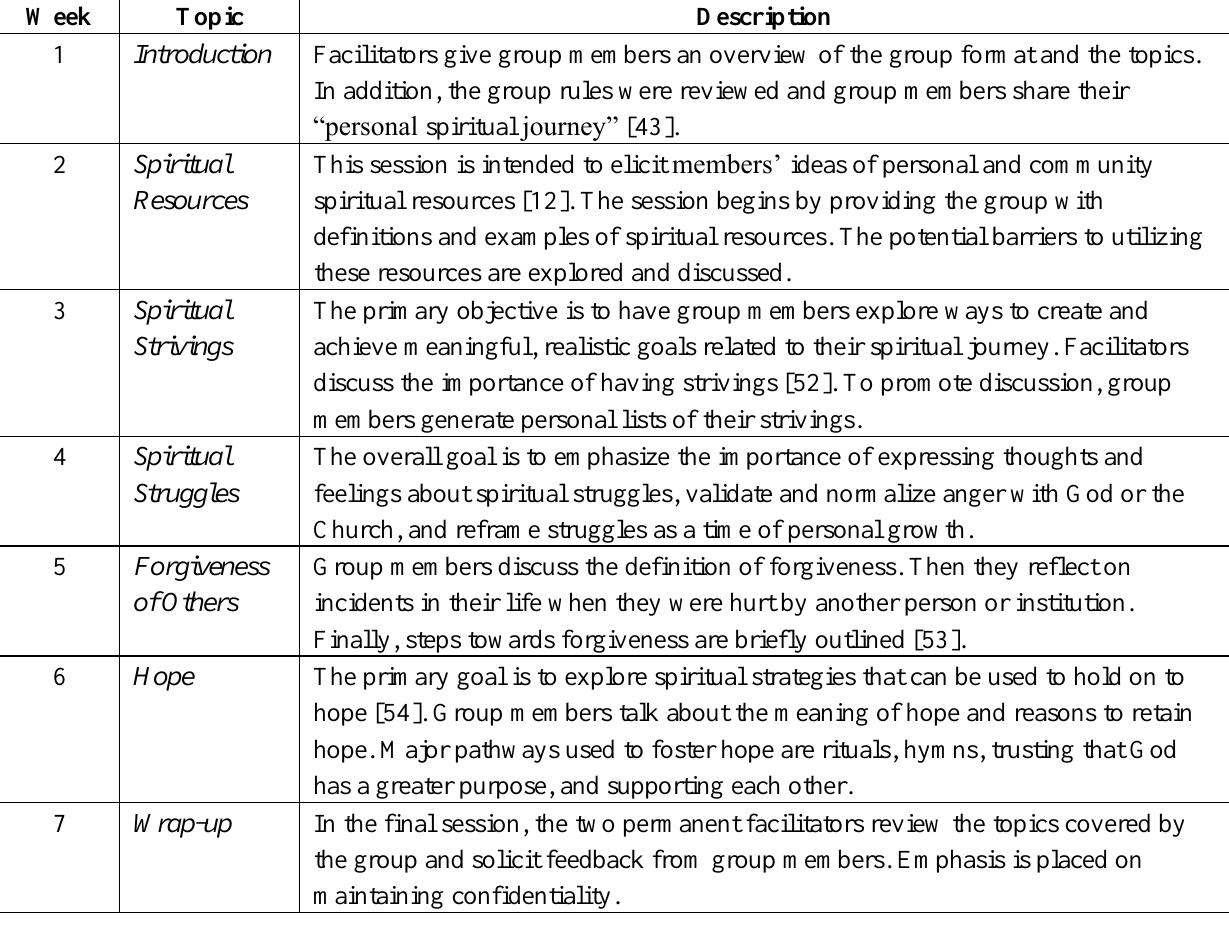
Table 1. Overview on the seven-week, semi-structured psycho-educational